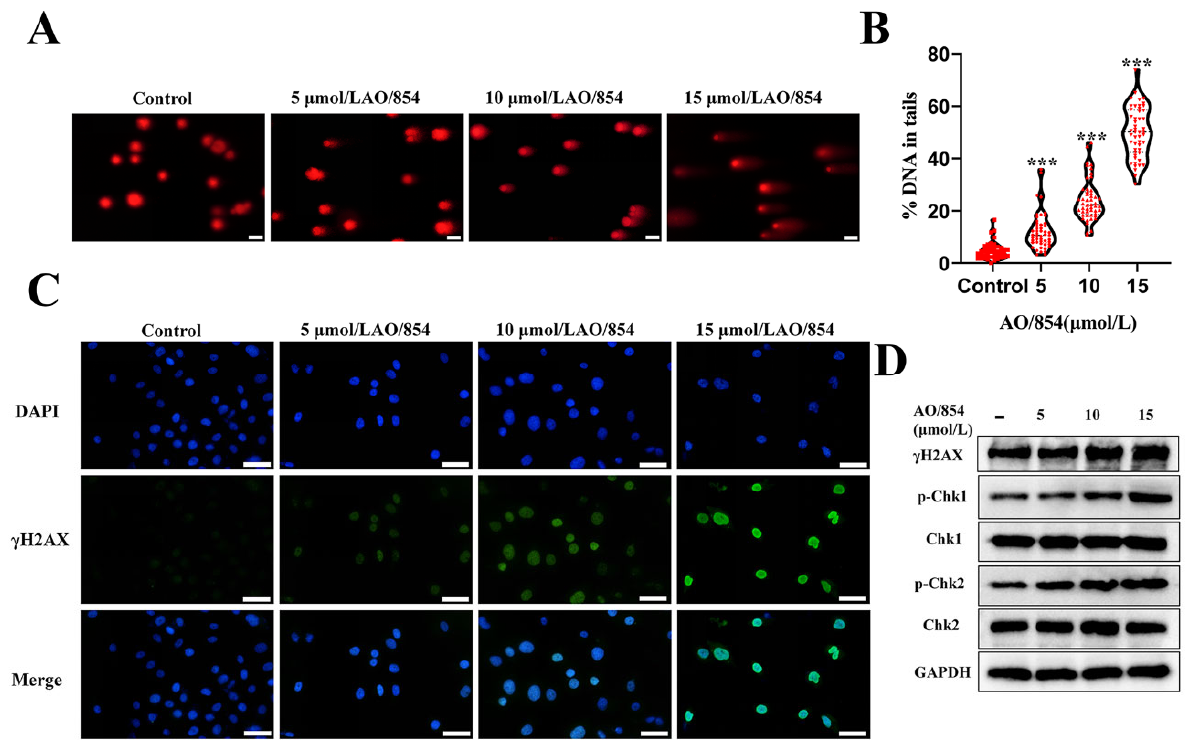
Figure 7. AO/854 ‐ induced DNA damage in PC3 cells. ( A ) Comet assay of PC3 cells treated with Figure 7. AO/854-induced DNA damage in PC3 cells. ( A ) Comet assay of PC3 cells treated with AO/854 (5, 10, and 15 μ mol/L) for 48 h. Scale bars: 50 μ m. ( B ) Quantification of %DNA in tails in AO/854 (5, 10, and 15 µ mol/L) for 48 h. Scale bars: 50 µ m. ( B ) Quantification of %DNA in tails in AO/854 (5, 10, and 15 μ mol/L) ‐ treated groups compared with DMSO ‐ treated group (control group). AO/854 (5, 10, and 15 µ mol/L)-treated groups compared with DMSO-treated group (control group). Quantification of 5 fields with 100 cells in total (*** p < 0.001). ( C ) Detection of γ H2AX foci (green) 48 h after AO/854 (5, 10, and 15 µ mol/L) treatment. Scale bars: 50 µ m. ( D ) Protein levels of γ H2AX, p-Chk1, Chk1, p-Chk2, and Chk2 as detected by western blotting after treated with AO/854 (5, 10, and 15 µ mol/L) for 48 h. GAPDH was examined as a loading